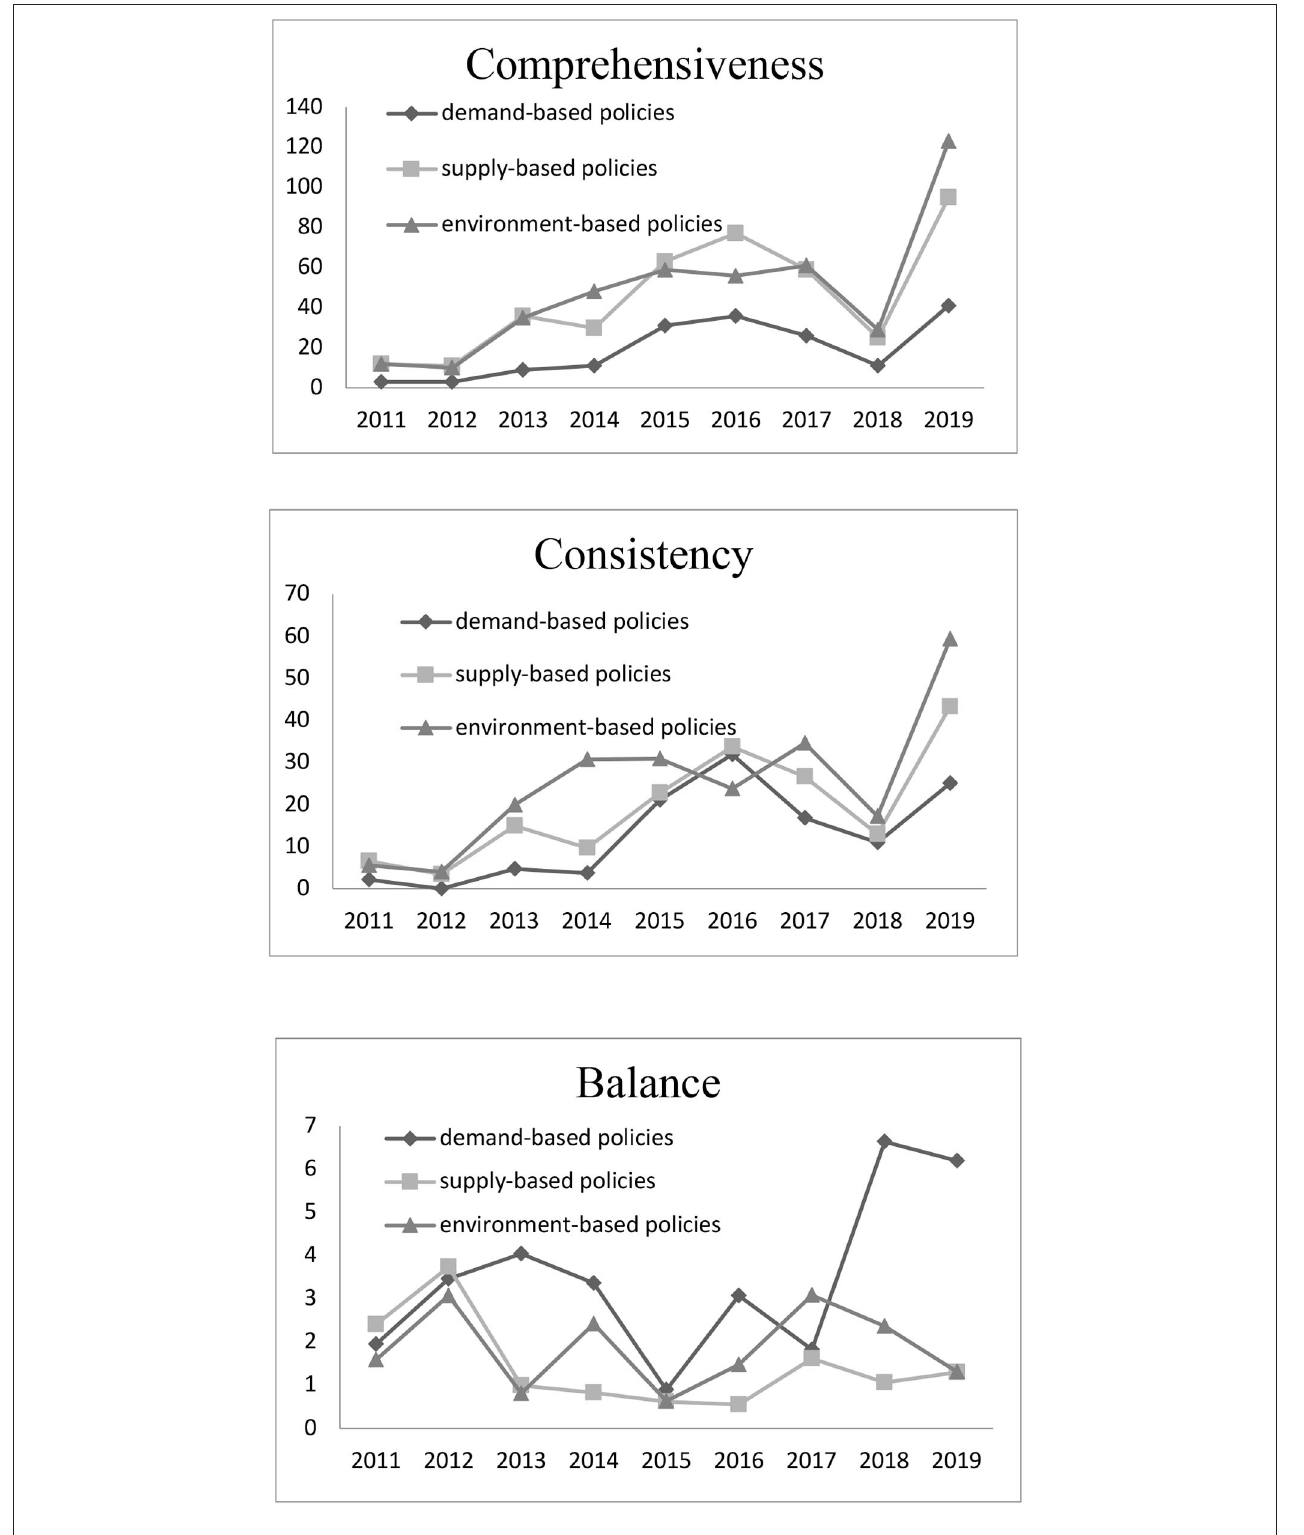
FIGURE 2 | Changes in the characteristics of different policies within the same policy instrument mix from 2011–2019.